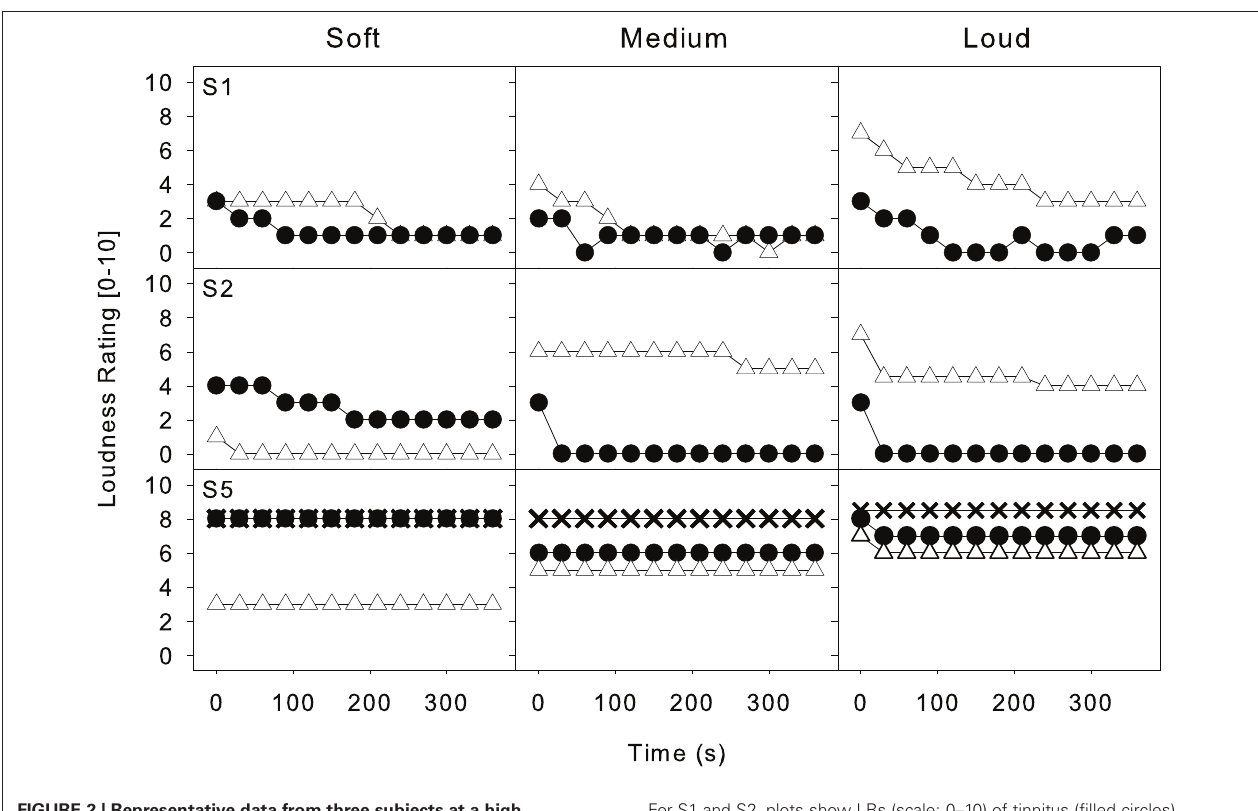
FIGURE 2 | Representative data from three subjects at a high rate (5000pps), apical electrode. Plots show tinnitus and electric stimulus loudness percepts across time at three different loudness levels for three representative subjects. Loudness levels are shown in columns; subjects S1, S2, and S5 are displayed in rows.